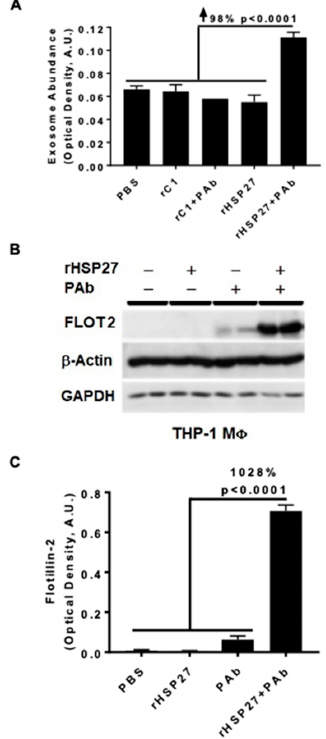
Figure 2. HSP27 IC Modulate Cholesterol Efflux and Expression of FLOT2. ( A ) M Φ exosome release was assayed in the media by ELISA. An anti-CD81 antibody was used to capture exosomes and anti-MHC-II / biotin antibody was used to detect the secondary exosomal biomarker (MHC-II). The HSP27 IC increased the release of exosomes by 98% compared to rC1 + PAb ( p < 0.0001). ( B ) Western blot analysis of Flotillin-2 (FLOT2) expression in THP-1 M Φ after 24 h treatment with PBS, rHSP27, PAb or rHSP27 + PAb, as indicated. ( C ) Densitometry quantification of the FLOT2 / β -actin. FLOT2 expression was enhanced by 1028% after treatment with the HSP27 IC (only). Each band was measured with ImageJ, and the data set was analyzed via one-way ANOVA. The bars represent the means of three independent experiments ± SEM ( p <